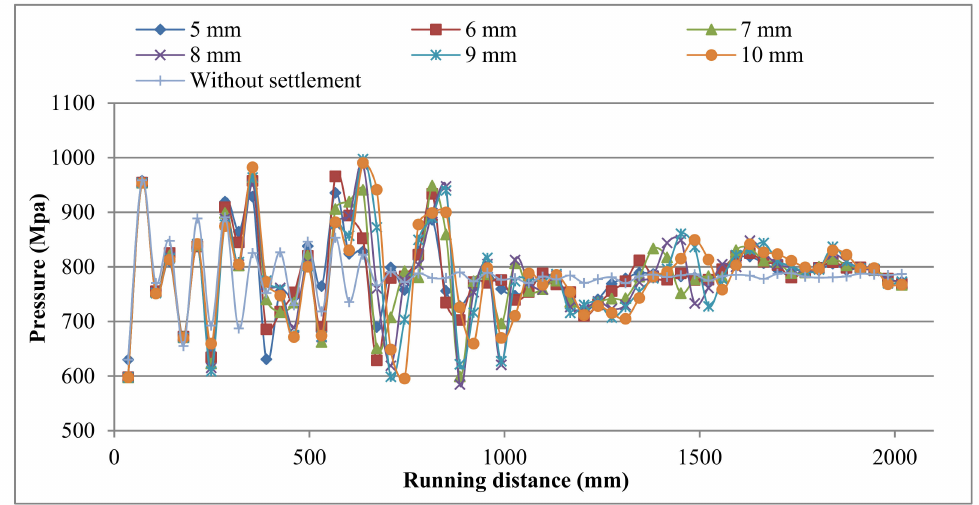
Figure 17. Wheel/rail pressure in states with and without